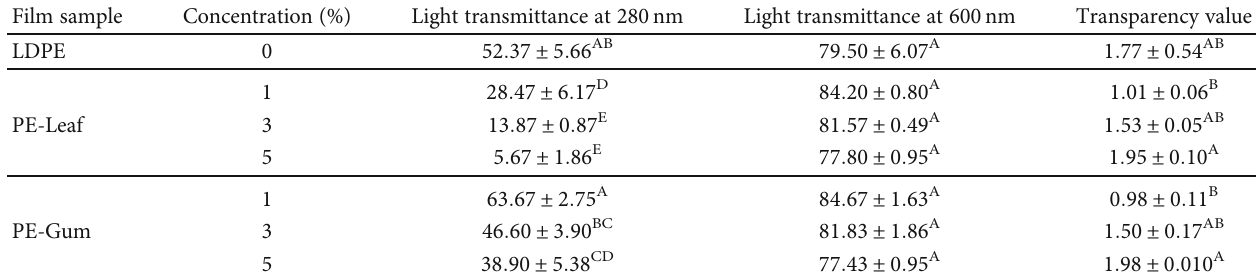
Table 4: Optical parameters ( mean ± SD ) of control and active fi lms.